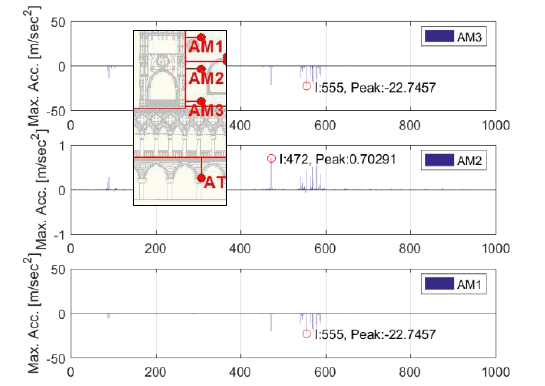
Figure 6. Maximum peak accelerations during one month: September 2011